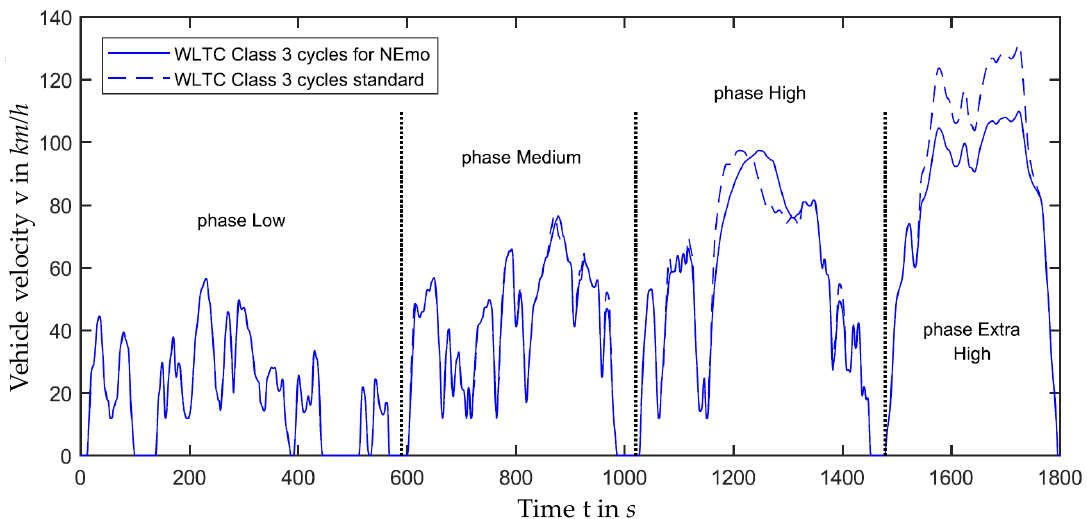
Figure 4. Speed curve of the standard and worldwide harmonized light vehicles test cycle (WLTC) driving cycle adapted for the NEmo [20,p.22].